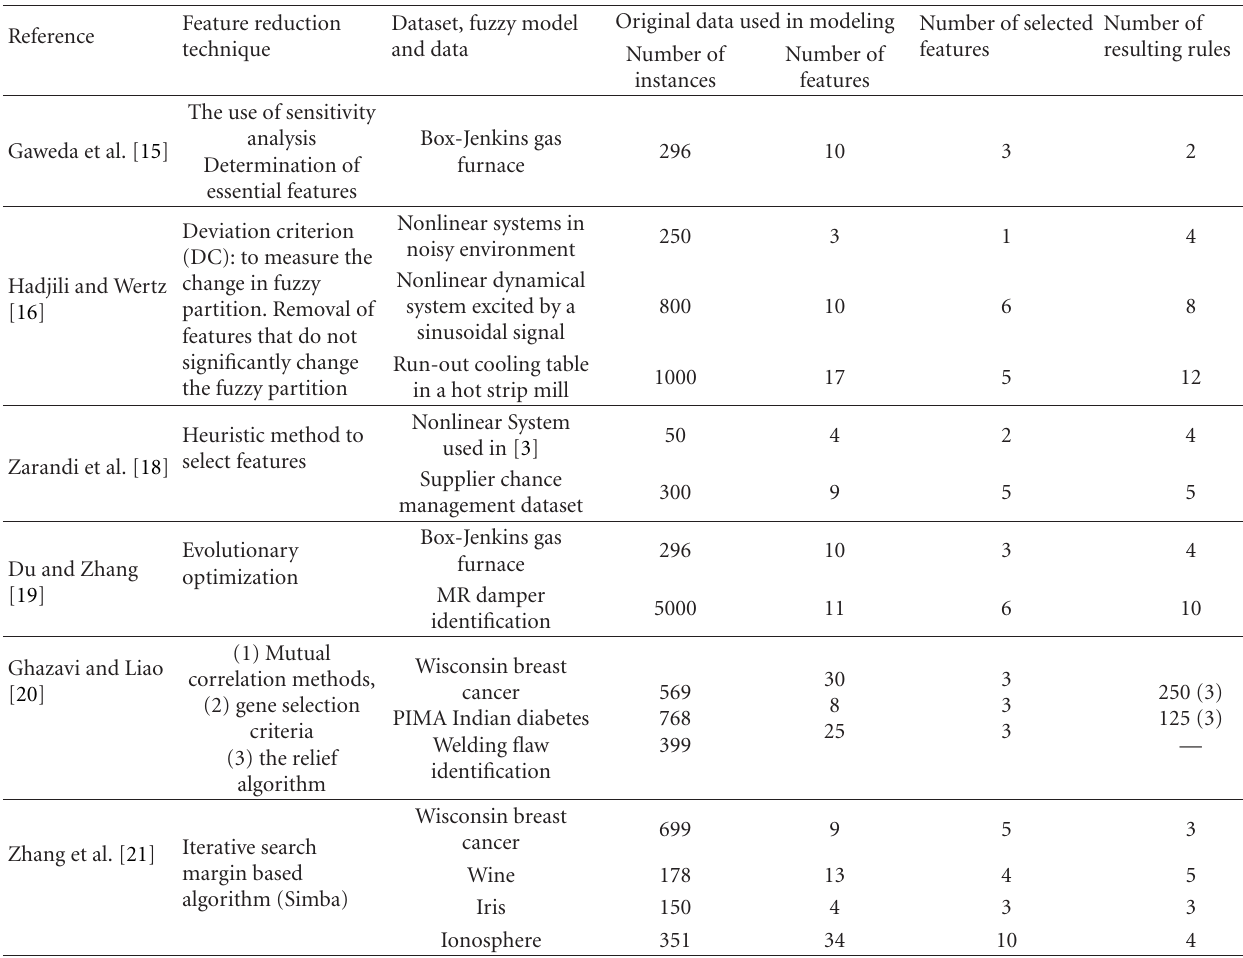
Table 1: A summary of selected studies in data and feature reduction in fuzzy modeling.